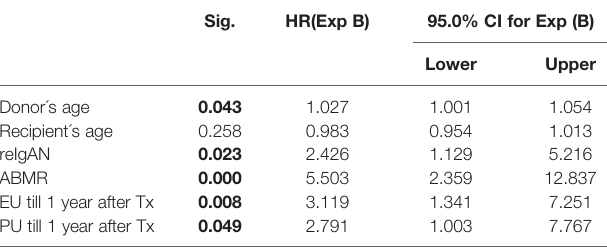
TABLE 6 | Multivariate Cox regression model for graft survival. Sig.